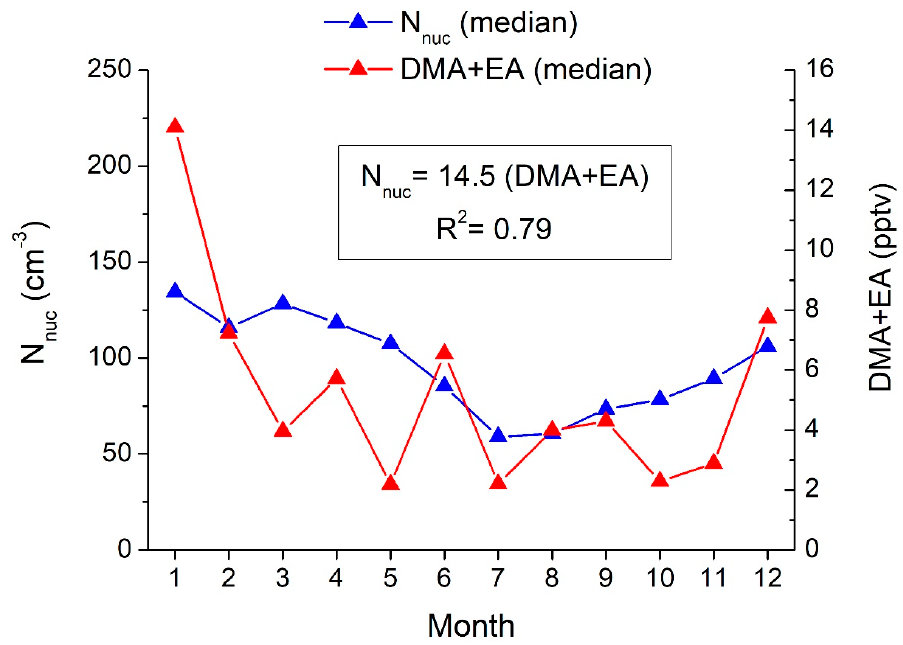
Figure 5. Monthly median variation of nucleation mode particle number concentration and DMA+EA amine concentration at Finokalia during the studied period.